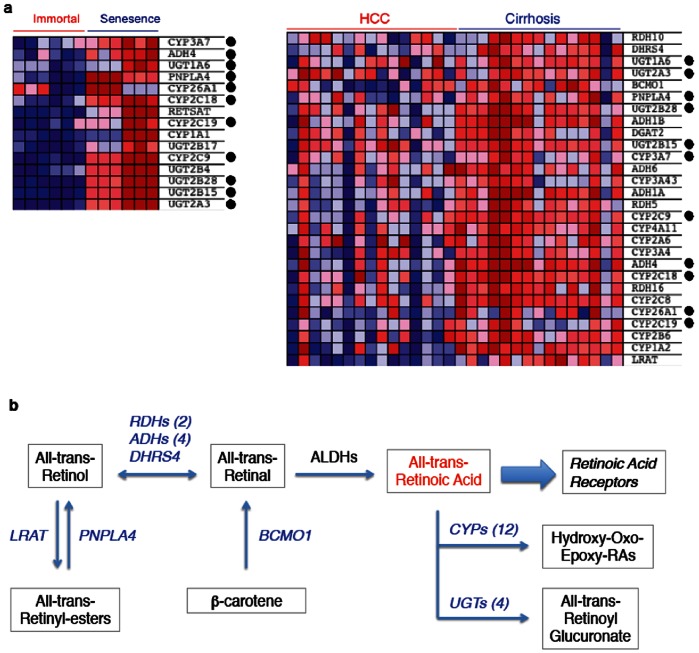
Comparative analysis of core enriched gene sets in Huh7 clones (senescent versus immortal) and diseased liver tissues (cirrhosis versus HCC) indicated that retinoid metabolism genes (“KEGG_RETINOL_METABOLISM”) undergo systematic changes in immortal cells and HCC, when compared to senescent cells and cirrhosis, respectively.(a) Heat map of core enriched retinoid metabolism genes in Huh7 clones (left) and diseased liver tissues (right). Red: up-regulated; blue: down-regulated. Genes commonly deregulated in both Huh7 clones and diseased liver tissues are indicated with a dot. (b) A simplified view of retinoid metabolism. Enzyme-encoding genes down-regulated in HCC are shown in blue. LRAT: lechitin retinol acetyl transferase, PNPLA4: patatin-like phospholipase domain containing-4, RDHs: retinol dehydrogenases; ADHs: alcohol dehydrogenases; DHRS4: dehydrogenase/reductase (SDR family) member-4; BCMO1: beta-carotene 15,15′-monooxygenase-1; CYPs: Cytochrome P-450 family proteins; UGTs: UDP glucoronosyltransferases.